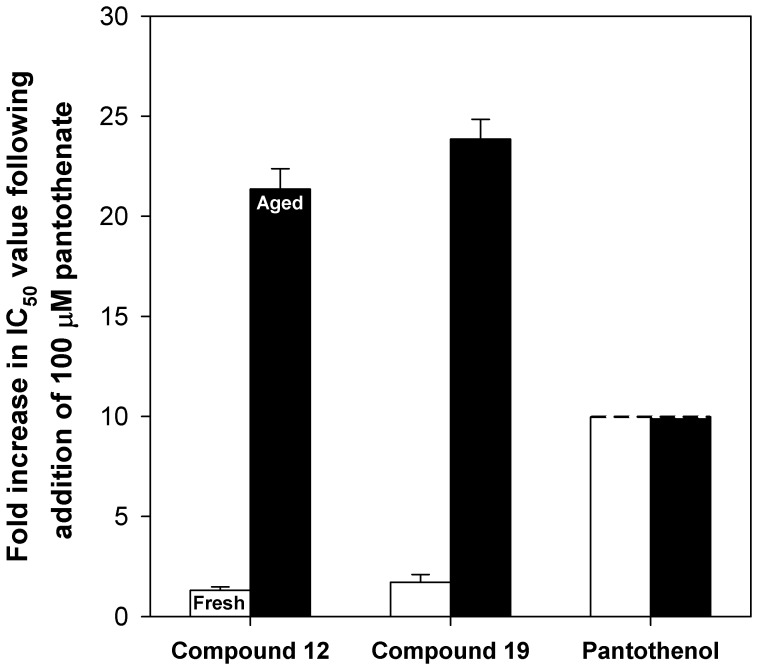
Effect of pantothenate supplementation on pantothenamide and pantothenol potency in fresh and aged Albumax-complete RPMI.The bars represent the fold-increases in the IC50 values of compound 12, compound 19 and pantothenol in Albumax-complete RPMI following supplementation with 100 µM pantothenate. The fold-increases in IC50 values were calculated by dividing each IC50 value measured against P. falciparum cultured in the presence of 100 µM pantothenate by the corresponding IC50 value measured against P. falciparum cultured in the presence of 1 µM pantothenate. The fold-increases in IC50 values were determined in assays performed using Albumax-complete RPMI stored for a maximum of 48 h at 4°C, and incubated at 37°C for a maximum of 1 h (fresh; open bar) or Albumax-complete RPMI stored for a minimum of one week at 4°C and incubated intermittently at 37°C, or, soon after preparation, incubated continuously at 37°C for up to 40 h (aged; closed bar). The fold-increases in IC50 values are averaged from between two and four independent experiments in which test compounds were tested in Albumax-complete RPMI containing 1 µM pantothenate and Albumax-complete RPMI supplemented with 100 µM pantothenate in parallel. Each experiment was performed in duplicate or triplicate, and error bars represent SEM or range/2. Pantothenol bars are shown with a broken edge to indicate that only a lower limit on the fold-increase in IC50 could be determined. This is because less than 50% inhibition of growth was observed at the highest pantothenol concentration tested (2 mM).